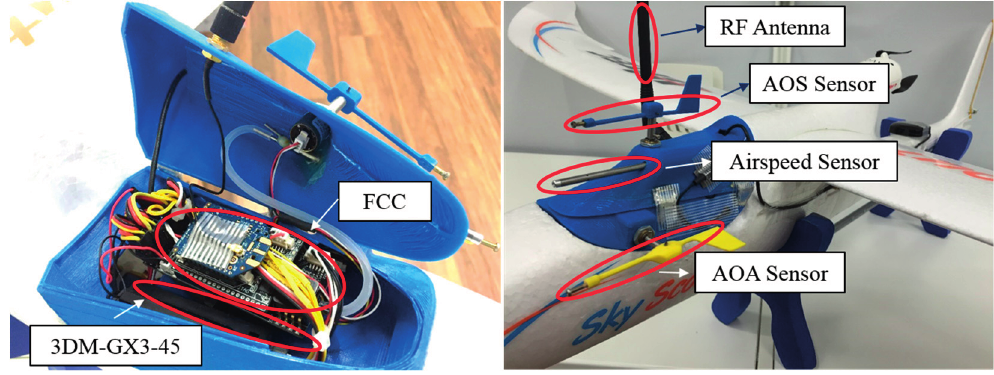
Figure 1. Sensors and avionics of an Unmanned Aerial Vehicle.